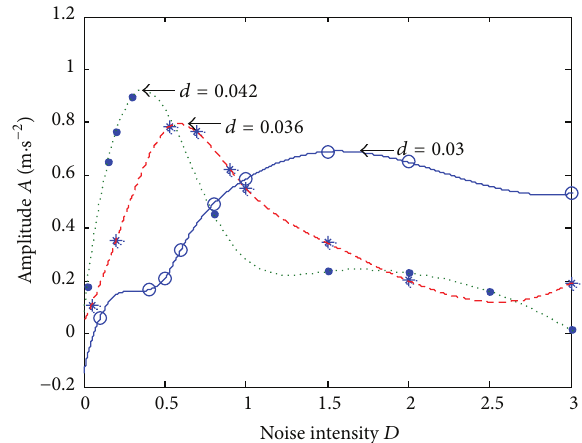
Figure 7: The variation curve of the output signal amplitude with the addition of noise 𝐷 under different 𝑏 value.